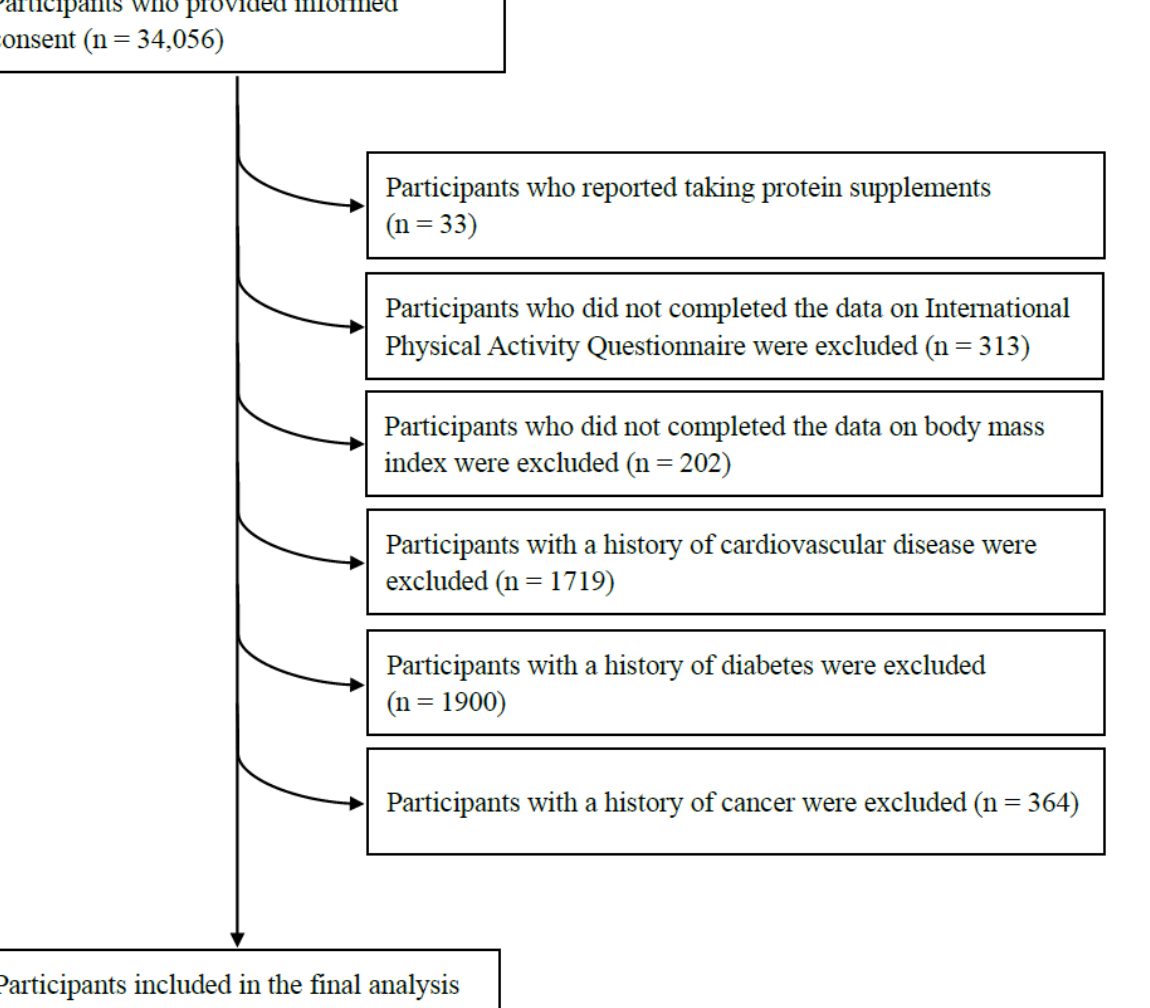
Figure 1. Flow chart describing the selection of participants for the current